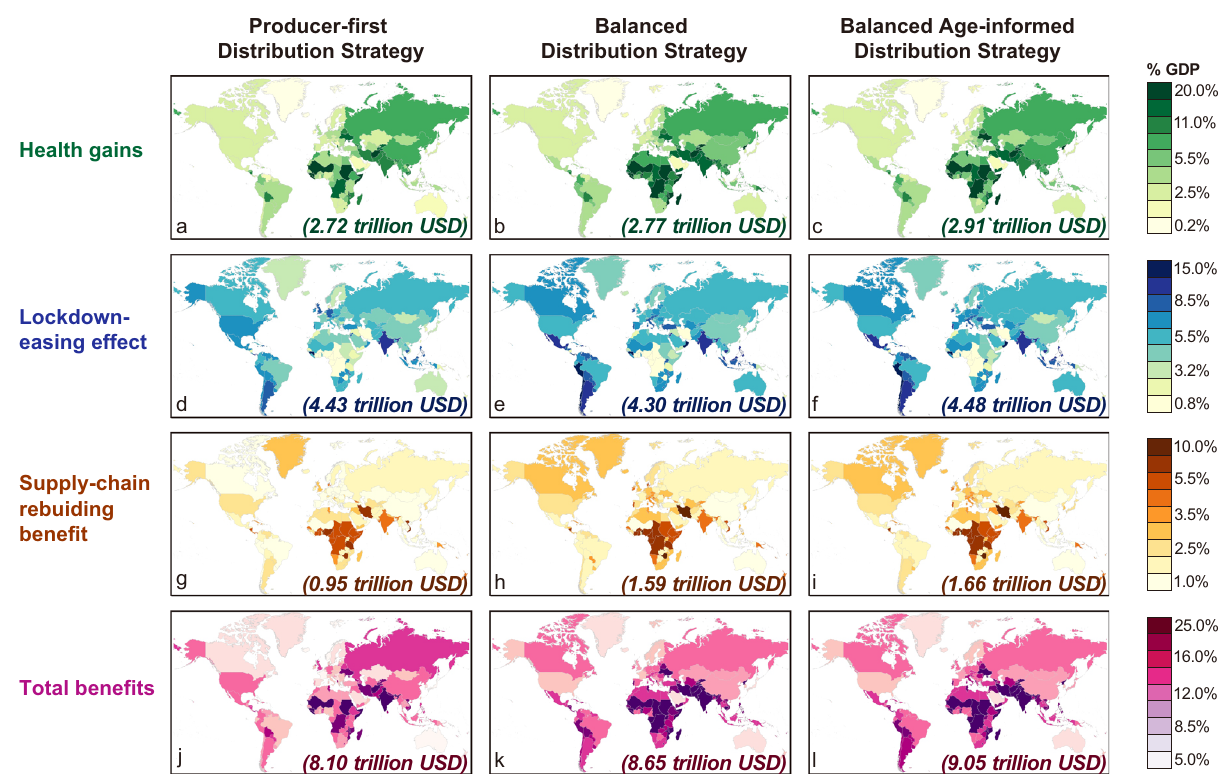
Fig. 2 | Socioeconomic bene fi ts of vaccination under different global vaccine- distribution strategies. Eachrow represents a category of bene fi t under different scenarios: a – c health gains; d – f bene fi ts from the alleviation of lockdown; g – i bene fi ts from global supply-chain recovery; j – l total bene fi ts. Each column represents a global vaccine allocation scenario (see Fig. 1): the left column shows theresultsundertheProducer- fi rstDistributionStrategy;themiddlecolumnshows the results under the Balanced Distribution Strategy; and the right column shows